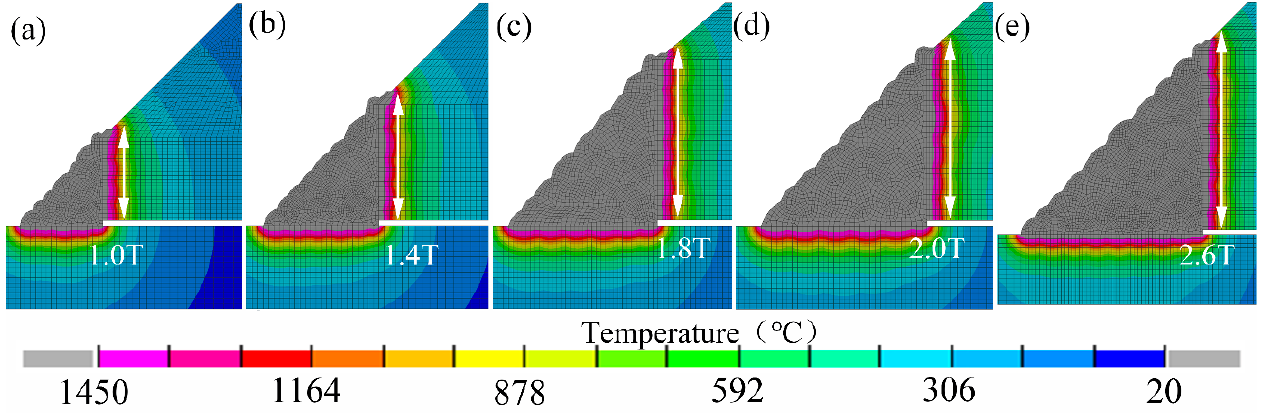
Figure 10. Welding temperature distributions: ( a ) 1.0T, ( b ) 1.4T, ( c ) 1.8T, ( d ) 2.0T, ( e ) 2.6T.